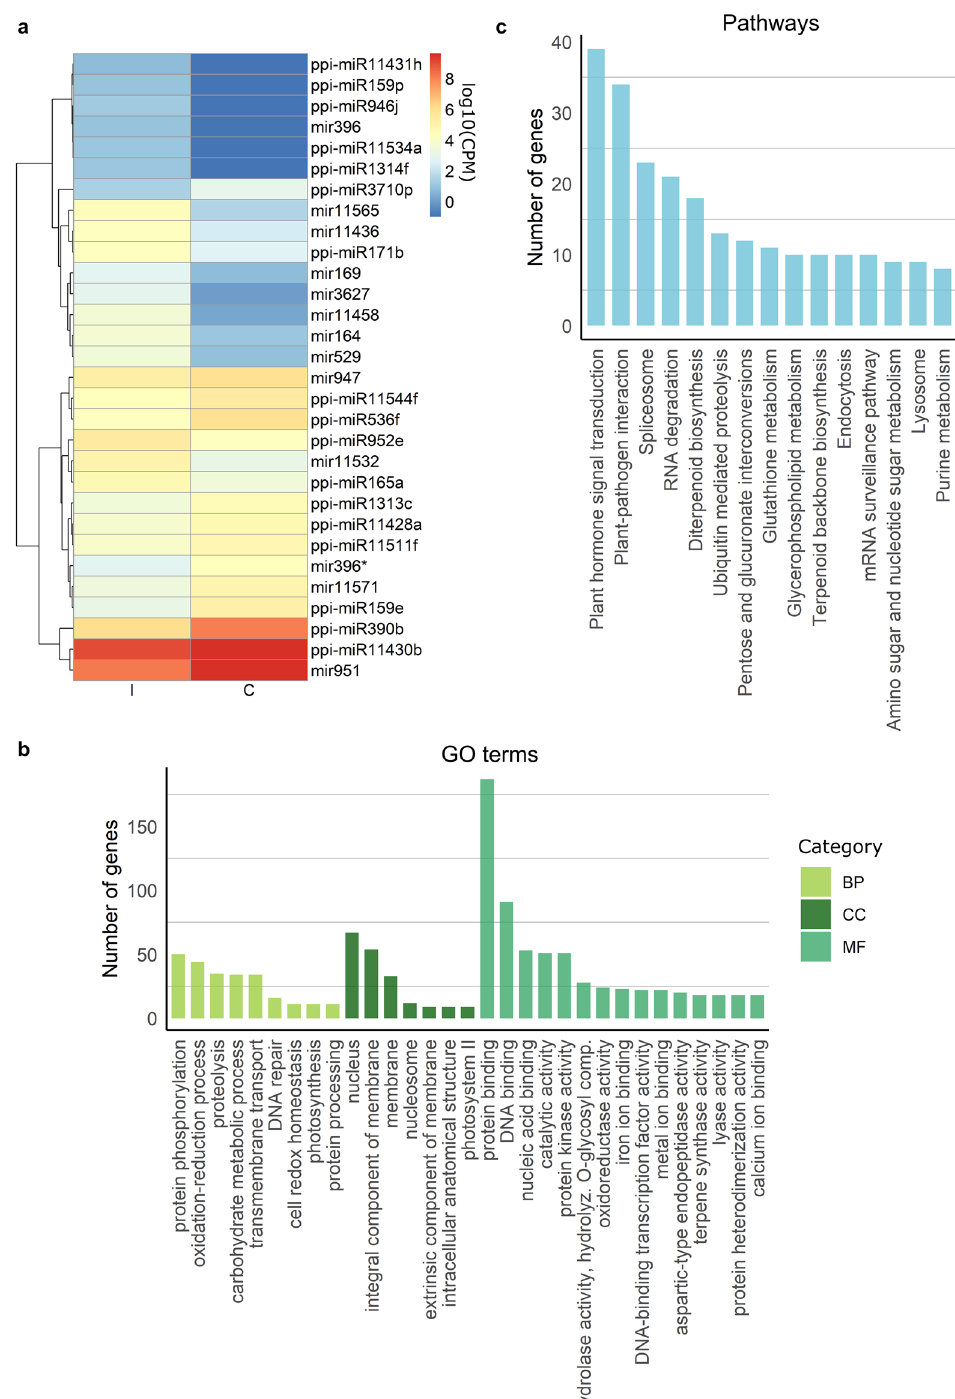
Figure 2. MiRNAs differentially expressed between inoculated (I) and control plants (C) and functional analysis of their target genes. ( a ) Average expression [log10(CPM)] for each conserved DE miRNA family, except for families where the miRNAs presented opposite expression patterns to each other, in which case isoform expression is represented. ( b ) GO terms and ( c ) pathways most represented in P. pinaster predicted target genes for the DE miRNAs. The y-axis represents the number of genes within each KEGG pathway 26,27 or GO term. BP biological process, CC cellular component, MF molecular function. Plots were generated with R 4.1.0 (https:// cran.r- proje ct. org/) pheatmap package (https:// cran.r- proje ct. org/ web/ packa ges/ pheat map/) and ggplot2 package (https:// ggplo t2. tidyv erse. org/). Inkscape 1.1 (https:// inksc ape. org/) was used to assemble the final